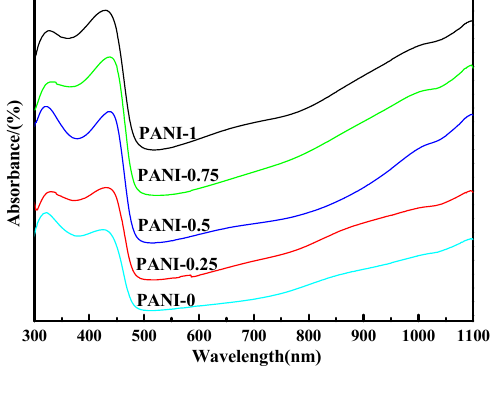
Figure 2. Ultraviolet-Visible (UV-Vis) spectra of PANI with different amounts of water in m